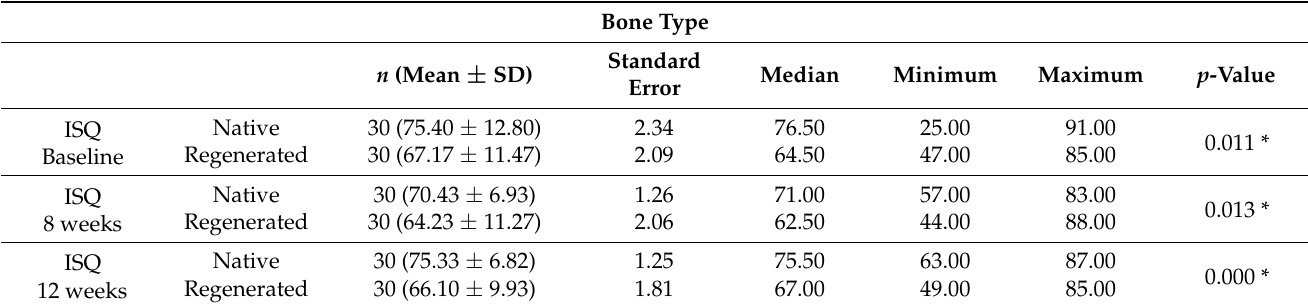
Table 2. Between-group comparison of ISQ values at baseline, 8 weeks, and 12